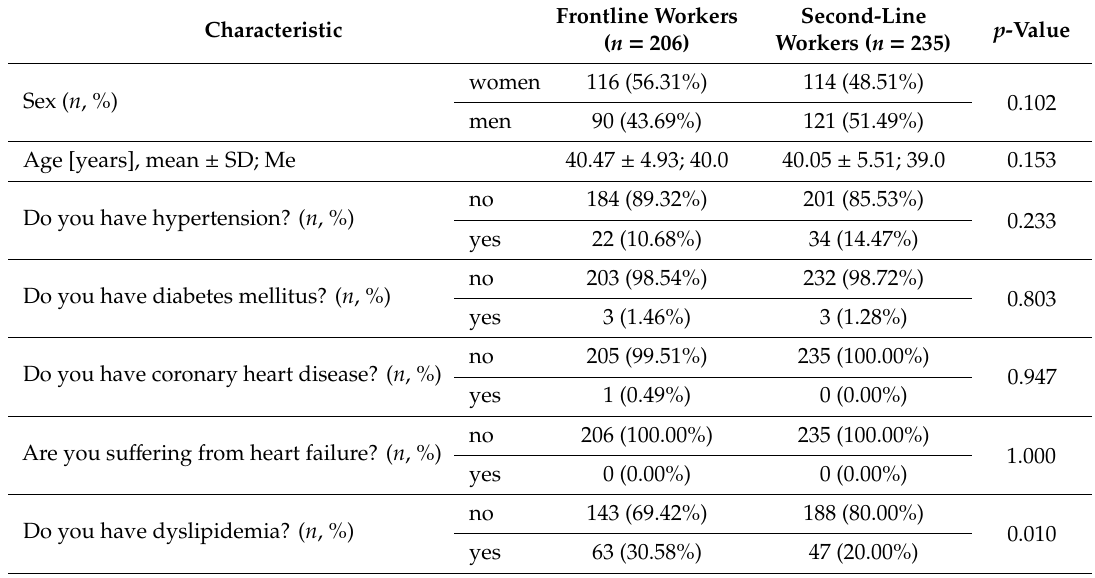
Table 1. Comparison of selected parameters between frontline and second-line workers.